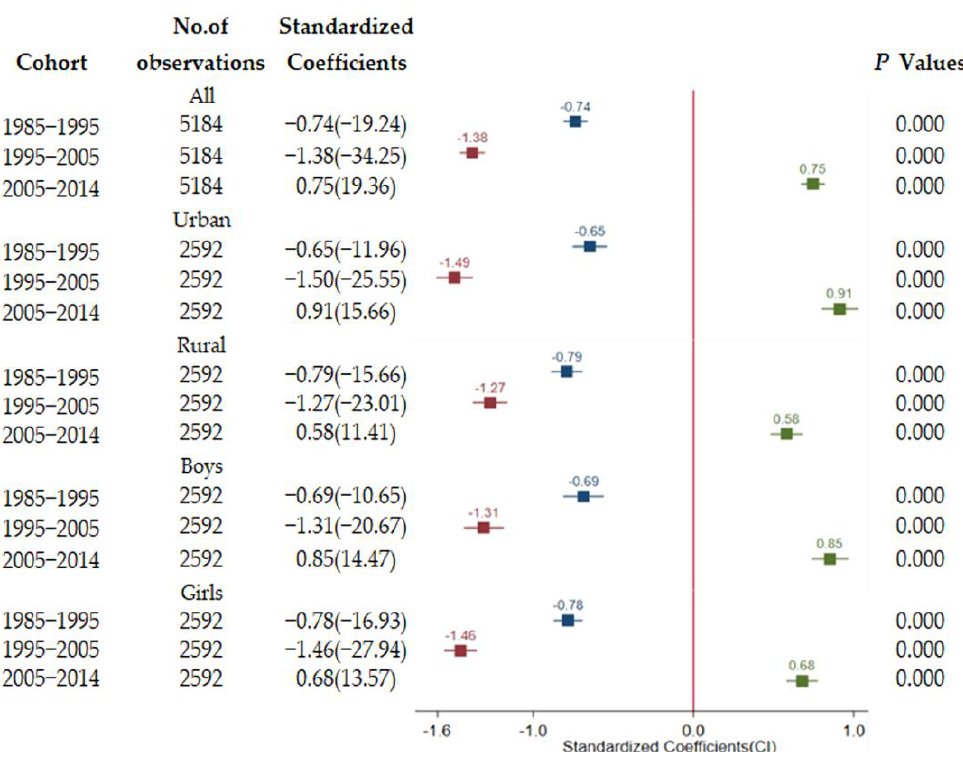
Figure 5. Longitudinal association of urbanization ratio with lung function. All regressions shown are adjusted for BMI, age, and provincial and time-specific effects and any time-varying differences common to all provinces. t statistics is shown in parentheses. GDP = gross domestic